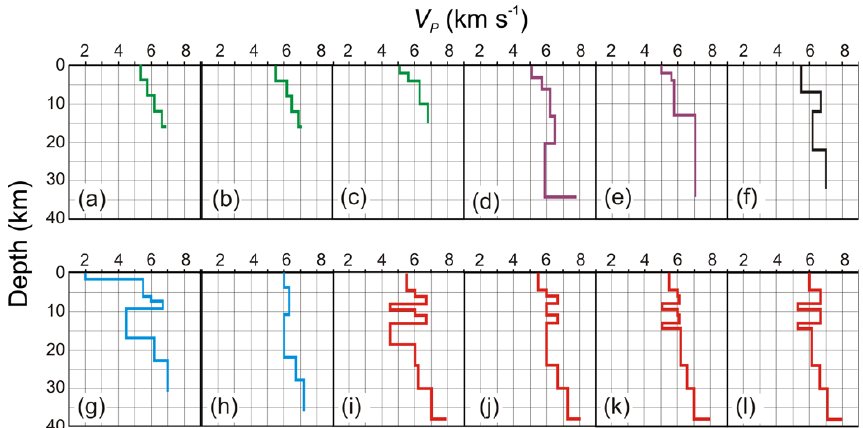
Fig. 6. Compilation of P -wave velocity ( V P ) models from the literature for the Sulmona area. Models derive (a–e) from seismological data, (f–h) from geophysical investigations and (i–l) from geological interpretation. Key references are as follows: (a) Bagh et al. (2007), (b) Chiarabba et al. (2009), (c) Chiarabba et al. (2010), (d) Chiarabba et al. (2005), (e) Chiarabba et al. (2005) modified, (f) Scarascia et al. (1994), (g) Patacca et al. (2008), (h) Di Luzio et al. (2009), (i-l) geostructural layering from Lavecchia and de Nardis (2009) and V P from many sources (Patacca et al., 2008; Di Luzio et al., 2009; Barchi et al., 2003; Trippetta et al., 2013).